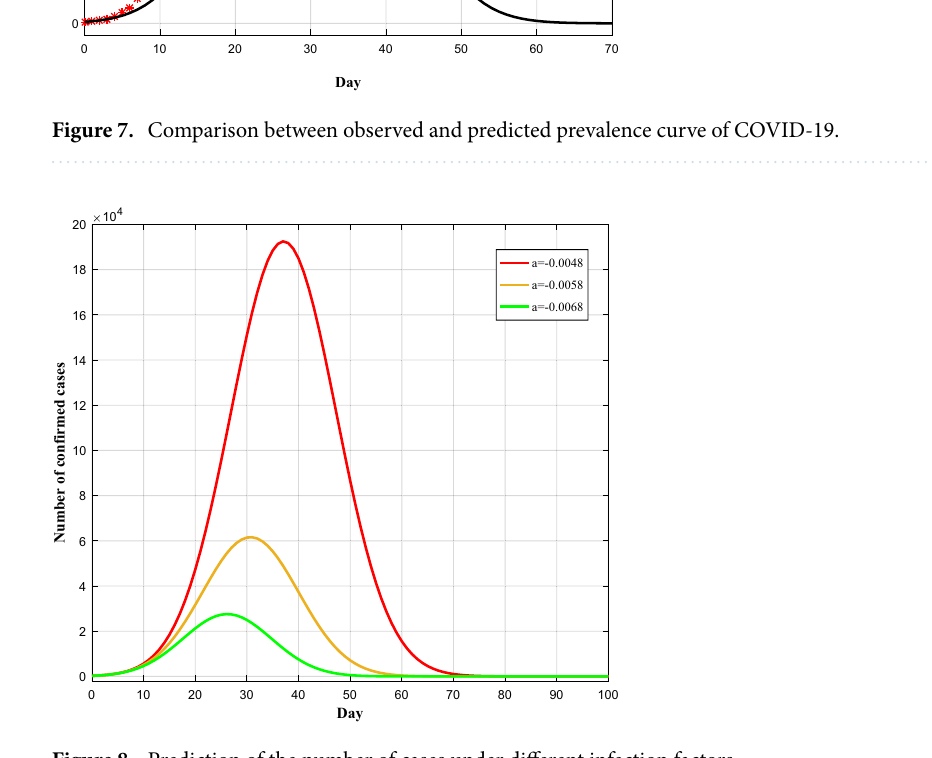
Figure 8. Prediction of the number of cases under different infection